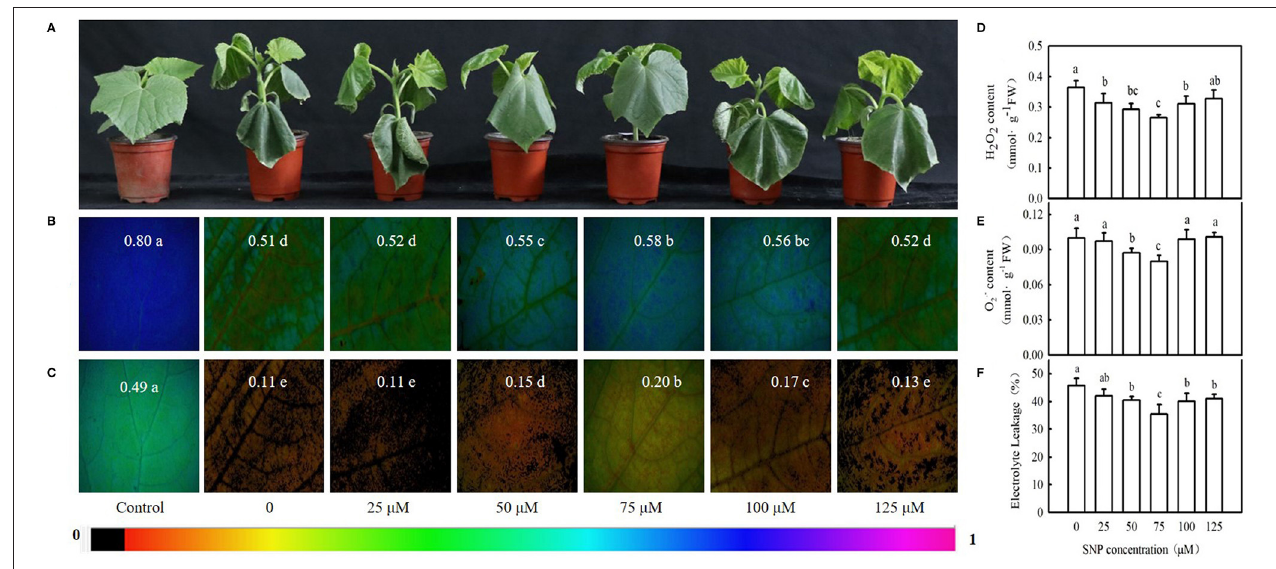
FIGURE 6 | Effect of sodium nitroprusside (SNP) on cold tolerance of cucumber seedlings. (A) Seedling phenotype, (B,C) Images of F v / F m and Φ PSII , respectively. Three-leaf stage seedlings were foliar sprayed with SNP (0, 25, 50, 75, 100, or 125 µ M, respectively) for 24h, and then were exposed to 5 ◦ C for 24h. The false color code depicted at the top of the image ranging from 0 (black) to 1 (purple) represents the degree of photoinhibition at PSII. (D) Hydrogen peroxide (H 2 O 2 ) content; (E) O 2 − content; and (F) EL rate. Seedlings were foliar sprayed with SNP (0, 25, 50, 75, 100, or 125 µ M, respectively) for 24h and then were exposed to 5 ◦ C for 72h. Data are represented as mean ± SD ( n = 3). Different letters indicate a significant difference between samples according to Duncan’s new multiple range test ( p <